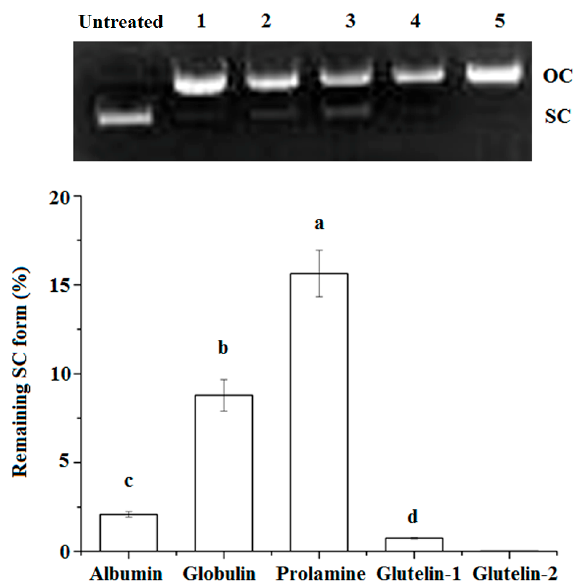
Figure 2. Protective effects of coconut cake protein fractions against DNA damage at 2 mg/mL concentration. SC, super-coiled form; OC, open-circular form; Different small letters a–d on the bar indicate significant difference ( p < 0.05) in the comparison between samples.